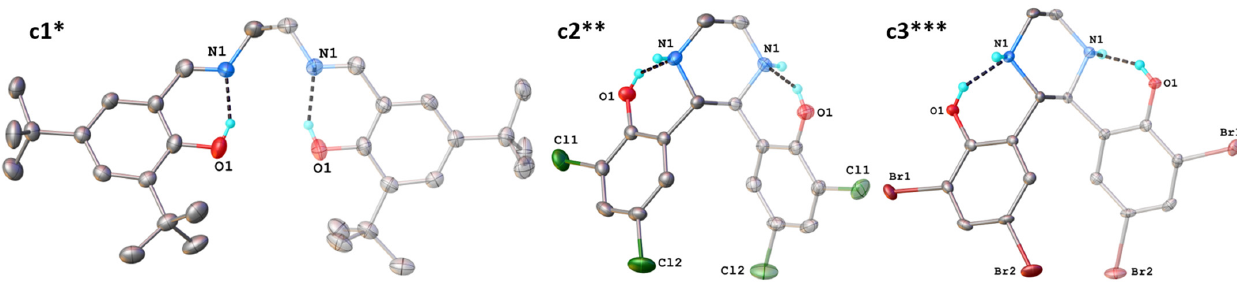
Figure 3. SC XRD analysis for compounds c1 - c3 (*—1 − x, + y, ½ − z (CCDC: 102872, 253998); **—